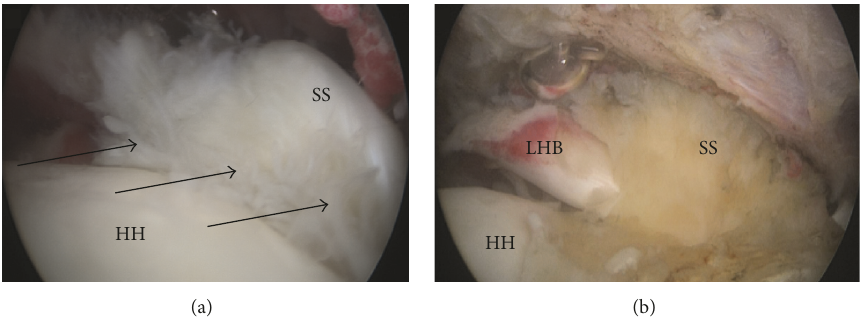
Figure 3: Arthroscopic view of a right shoulder viewed from posterior portal. (a) The supraspinatus tendon had the appearance of ulcerations and flanges of the bursal-side (sea anemone appearance, black arrows) and (b) after debridement of the flanges, the tendon that flopped on itself and the long head of the biceps and healed on the anterior humerus had an unusual orientation (HH, humeral head; LHB, long head of the biceps; SS, supraspinatus tendon).